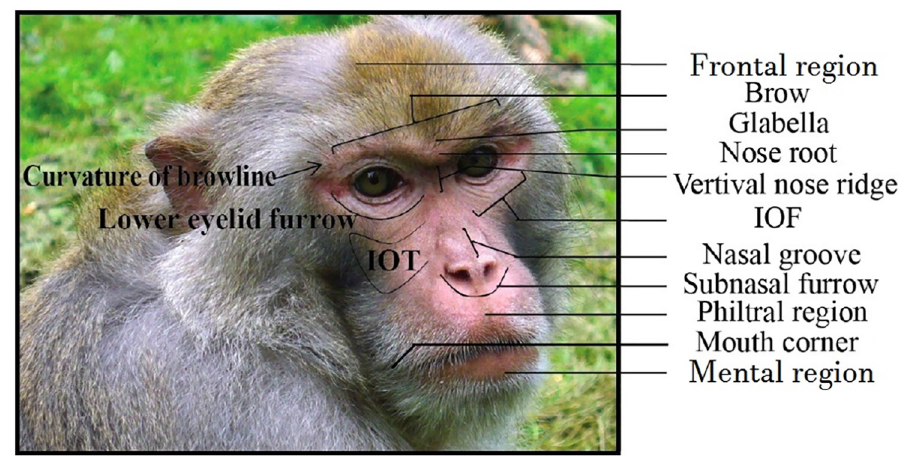
Fig 1. Facial landmarks in rhesus macaques (adapted from [15]). IOT—Infraorbital triangle, IOF—Infraorbital furrow.